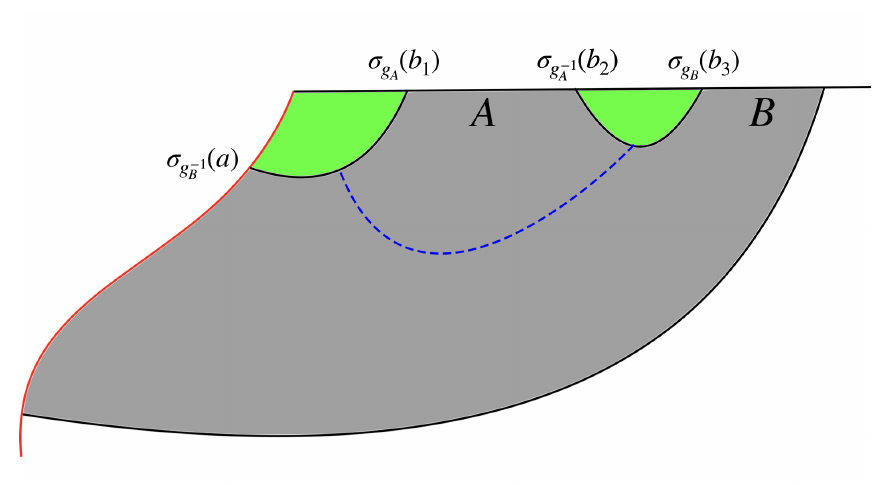
Figure 8: Schematic of the island proposal-II for the entanglement negativity of the disjoint intervals in phase-II. The emergent twist operators depicted for the reflected entropy. Figure modified from [ 68